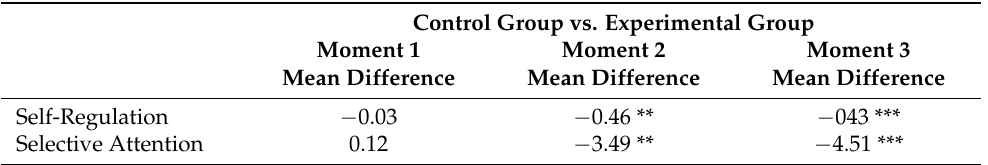
Table 3. Bonferroni’s adjusted p values for all possible pairwise differences among two dependent variables of the between-subjects